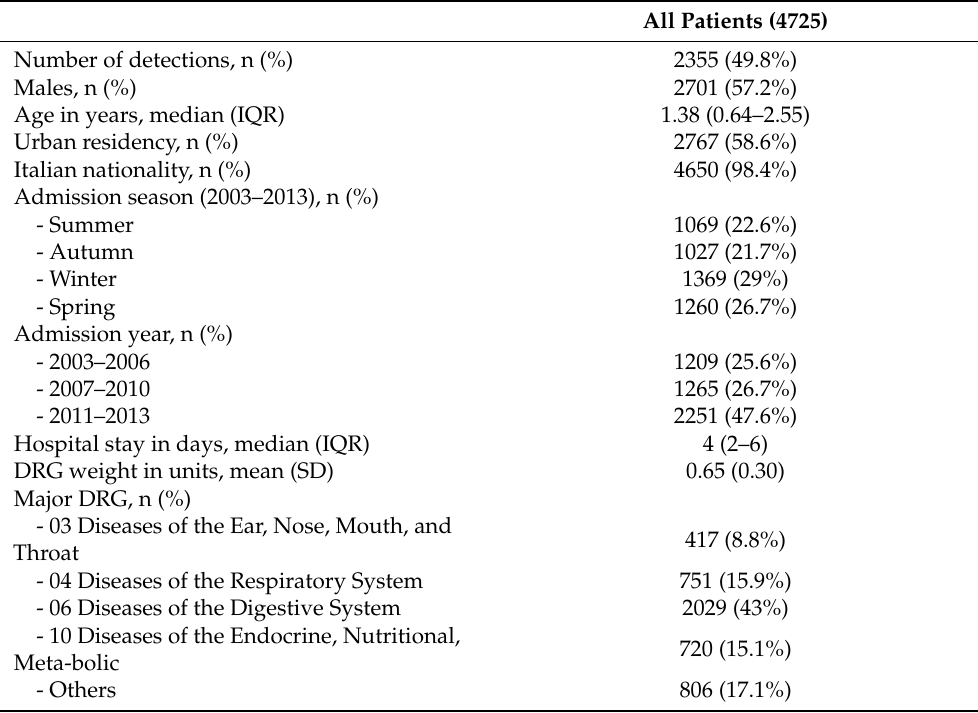
Table 1. Epidemiological factors and clinical features in hospitalized children (n = 4725) with viral acute